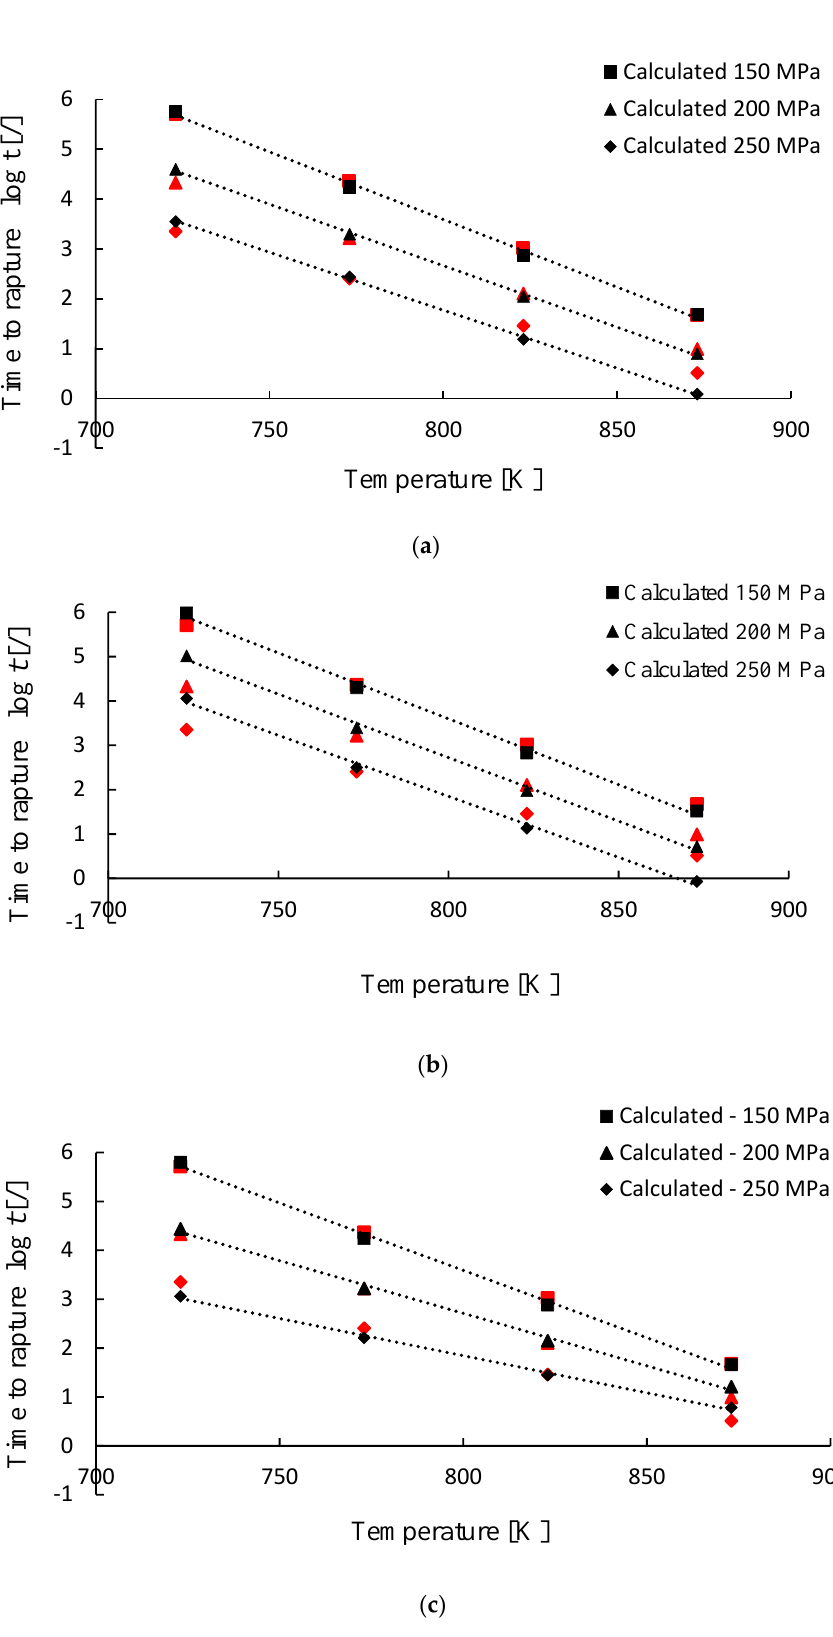
Figure 5. Creep-model performance compared with creep-test results. Model specifications are as follows: linear fit function (see Figure 4) and ( a ) C = 18, ( b ) C = 20 and ( c ) C = f ( σ ) with C ( 150 MPa ) = 18.31, C ( 200 MPa ) = 14.25 and C ( 250 MPa ) = 10.20, respectively. Red points represent the measured values.